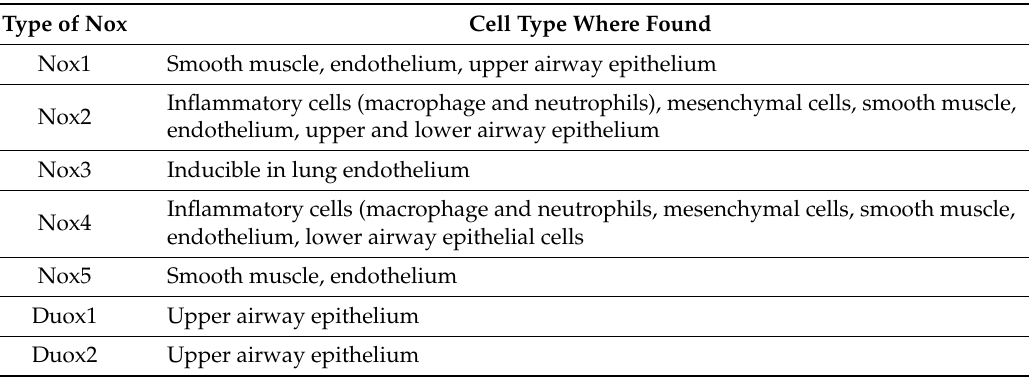
Table 1. Lung tissue distribution of Nox